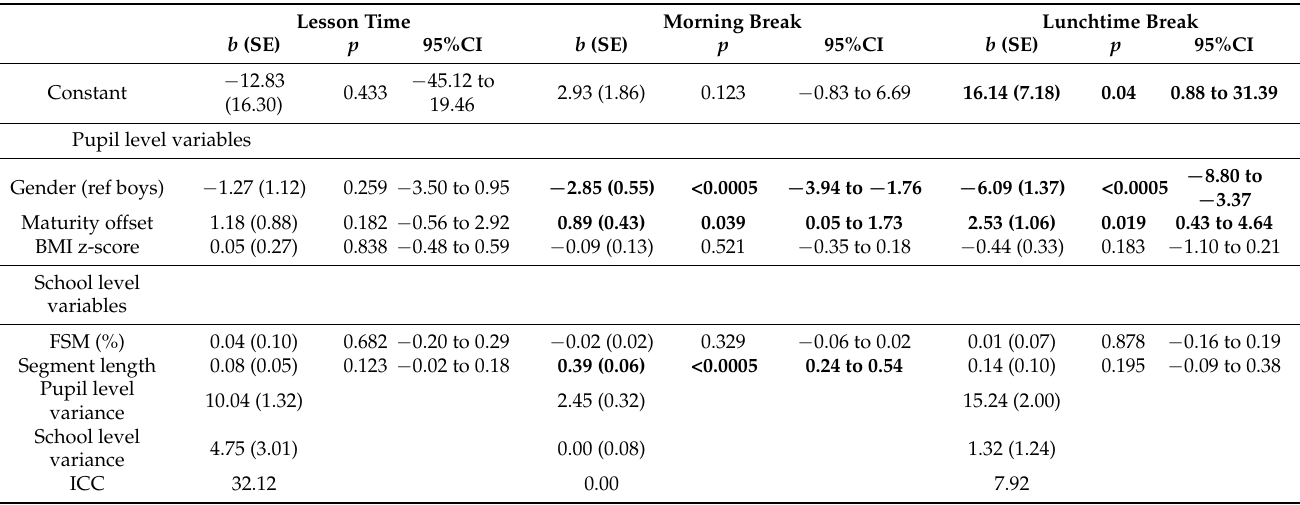
Table 2. Multi-level associations between pupil- and school-level predictors and moderate-to-vigorous physical activity across school segments.